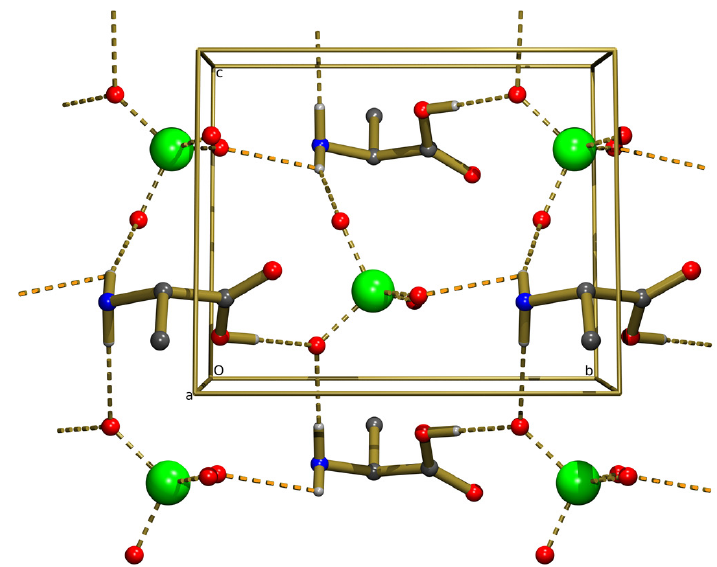
Figure 4. Two-dimensional H-bonded networks parallel to the (100) planes. Alternating H-bonded L-alaninum and perrhenate chains parallel to the b and c axes are shown. The last H-bond of Table 4 (N1-H1A…O4) is shown in a different color.